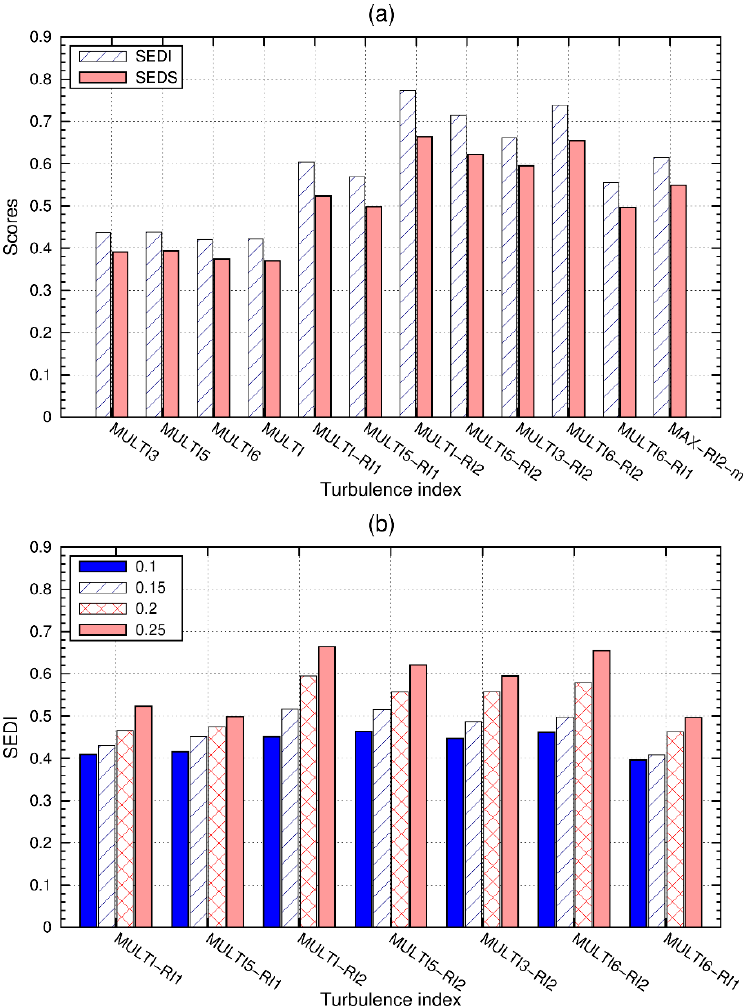
Figure 9. ( a ) SEDI and SEDS, regarding the ability to predict MOG turbulence, for different combined indices with coef = 0.25. The values of these scores correspond to their maximum for the threshold that has a BIAS close to 1. ( b ) Performance of the indices as a function of the value of coef.